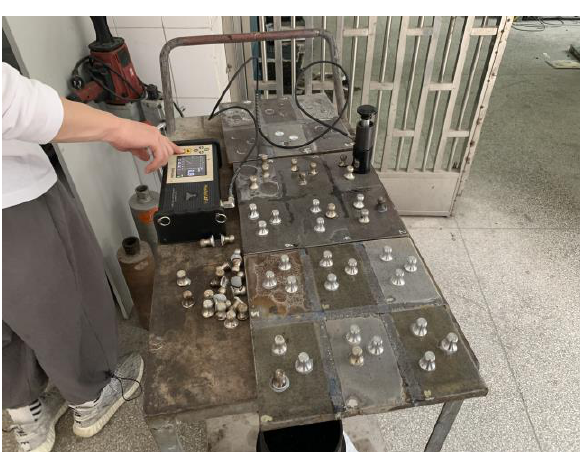
Figure 5. Pull-out tests.